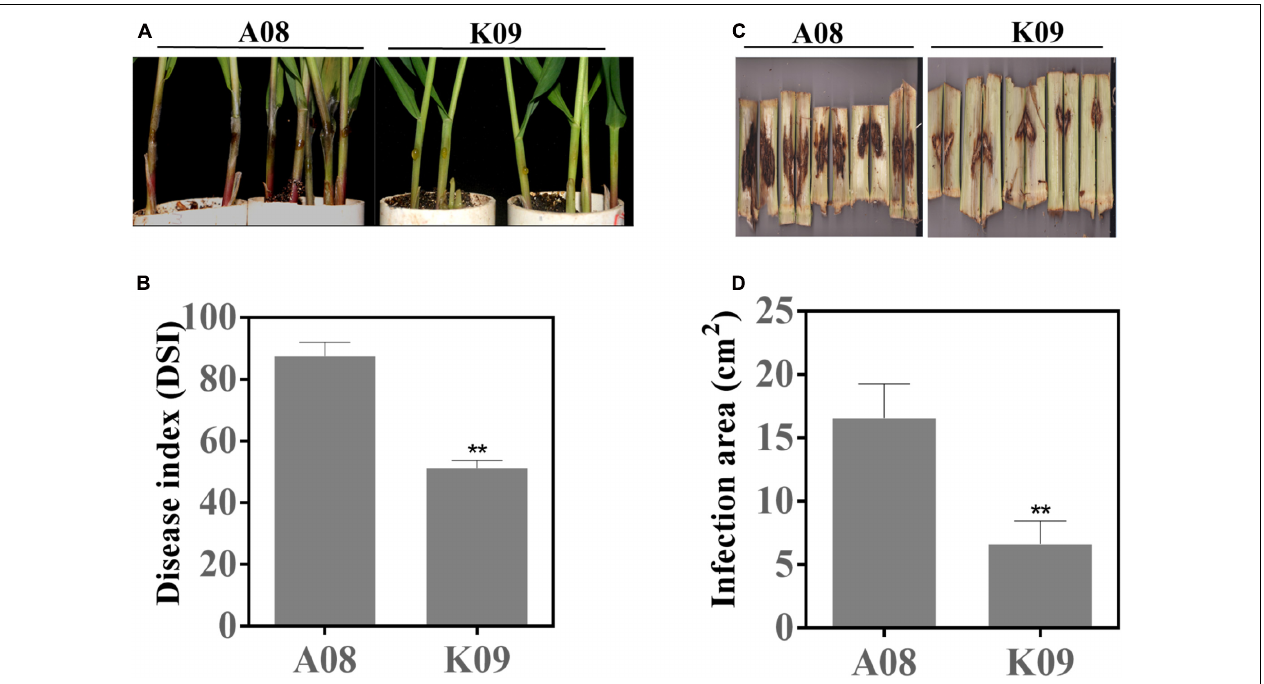
FIGURE 1 | GSR phenotype of susceptible line A08 and resistant line K09 upon infection with Fusarium graminearum . (A) Seedling GSR phenotypes of A08 and K09. The phenotype was recorded at 3 dpi. (B) Quantification of seedling GSR disease index (DSI) of A08 and K09 shown in (A) . (C) Field GSR phenotype of A08 and K09 recorded at 15 dpi. (D) GSR disease areas on the stems of A08 and K09 in the field condition. Both seedling assay and field assay were conducted for at least three replicates with consistent results obtained, with at least 10 plants per replication. **Statistically significant ( p < 0.01) between mock and inoculation treatments analyzed by t -test.